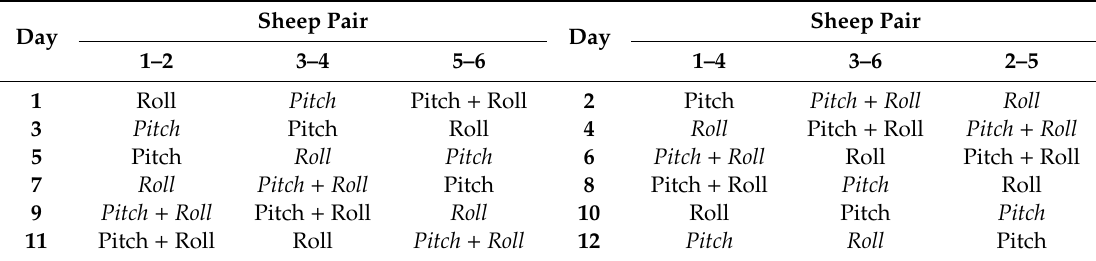
Table A1. Combinations of sequences and movements tested for each day [57]. The two-factor factorial design for Experiment 1, with motion type (pitch, roll, or both pitch and roll) and treatment sequence (regular or irregular - indicated in normal or italic font, respectively), as the two factors. Individual sheep were designated with the numbers 1 through to